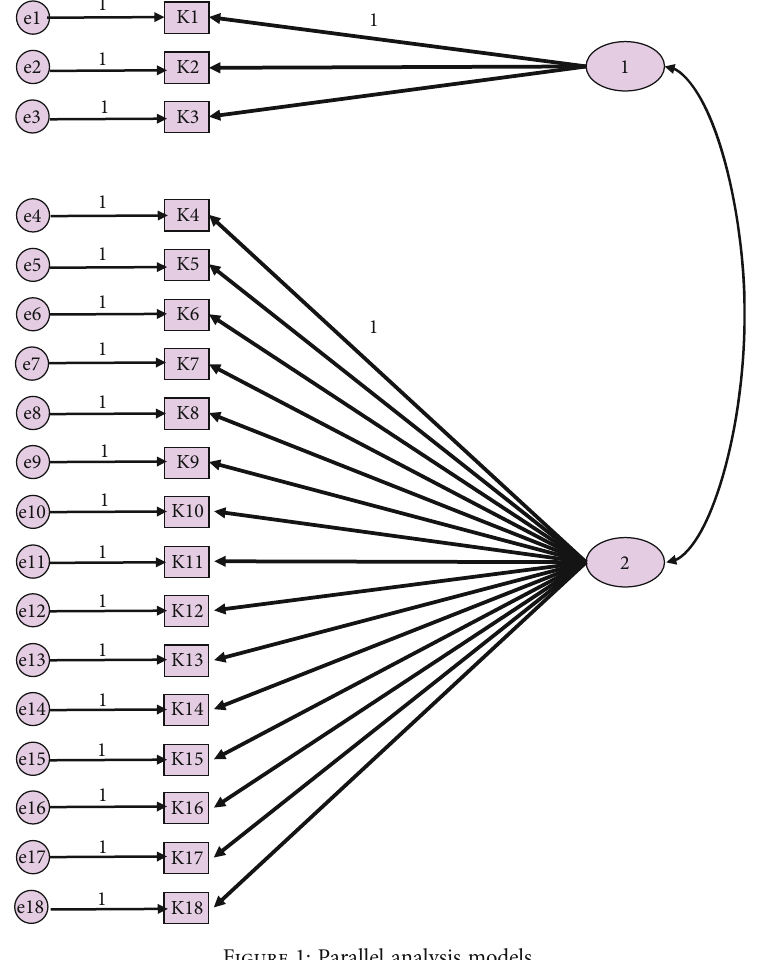
Figure 1: Parallel analysis models. Table 4: Goodness-of- fi t